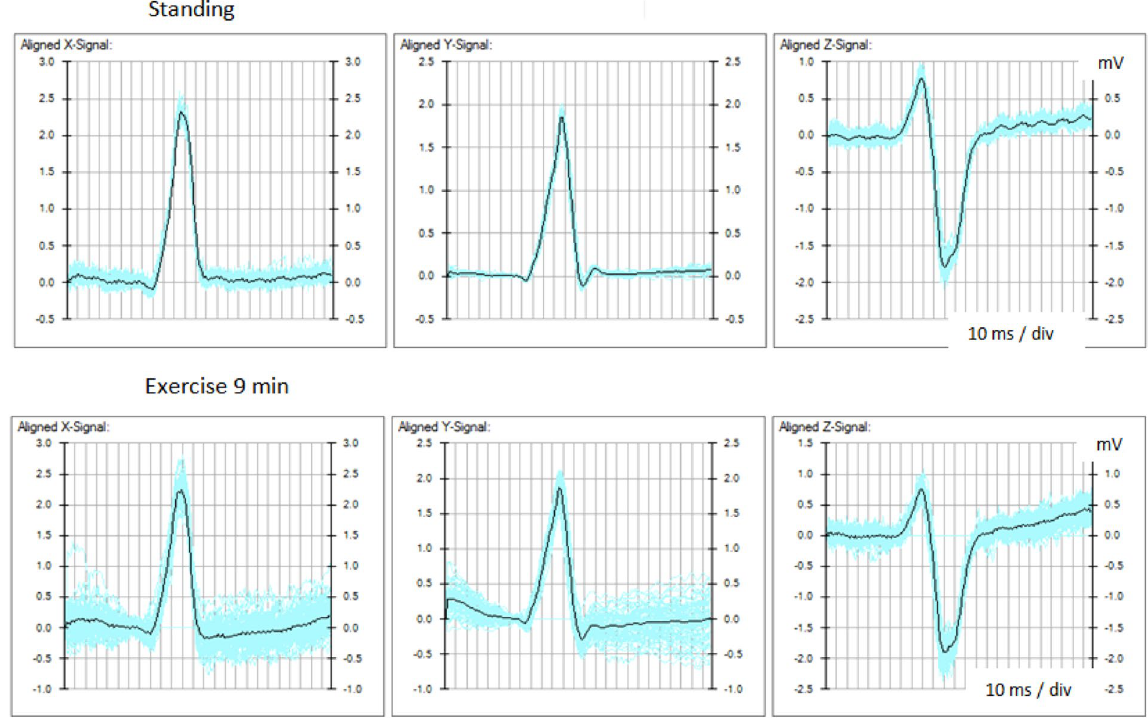
Figure 1. Averaged QRS signal. The continuous black line shows the baseline adjusted, averaged QRS waveform extracted from the variations of the signal (blue) due to electromyographic and other electrical potentials recorded before and at the peak of exercise.